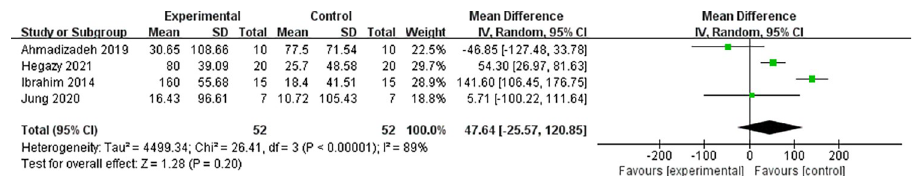
Fig 6. Effect of WBV training on 6MWT walking speed of children with cerebral palsy.